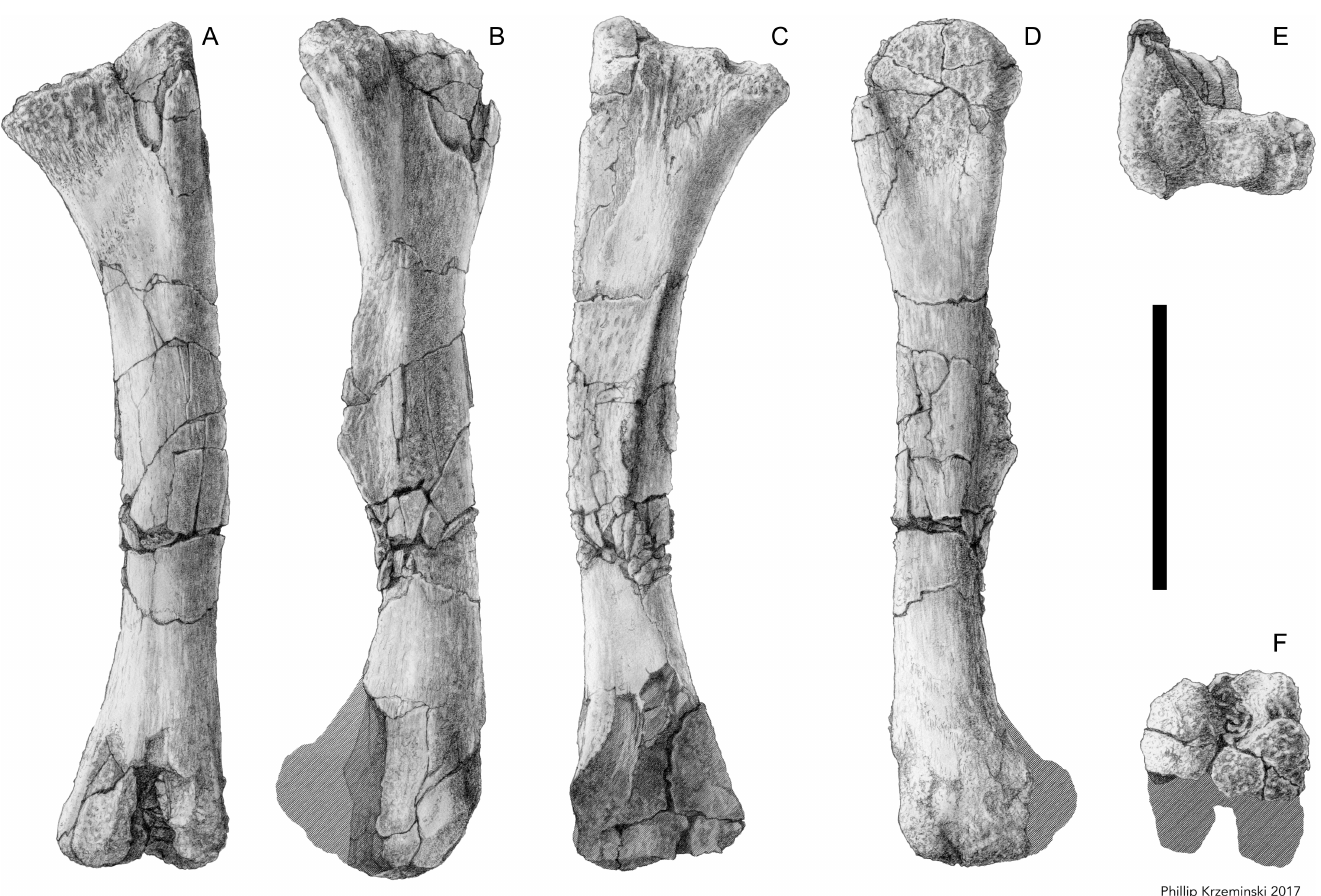
Figure 2. RAM 9396, left femur of cf. Edmontosaurus annectens , drawn in A) anterior; B) medial; C) posterior; D) lateral; E) proximal; and F) distal views. Missing portions of the condyles are indicated with gray shading. Scale bar equals 10 cm. Illustrated by Phillip Krzeminski, used with